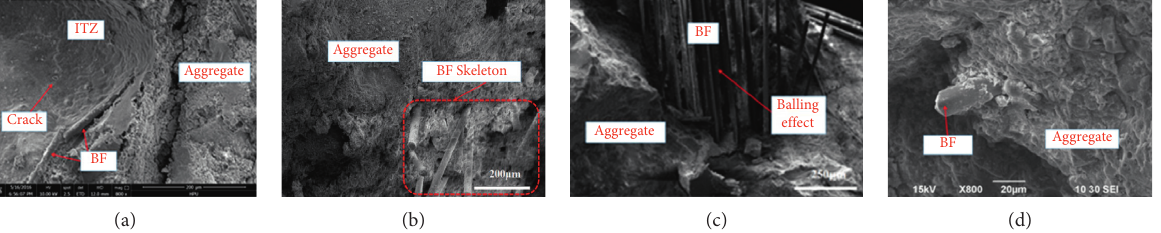
Figure 8: Bonding mode of fiber substrate. (a) Matrix around fibers. (b) Fiber random dispersion. (c) Fiber dense distribution. (d) Fiber breakage under stress.